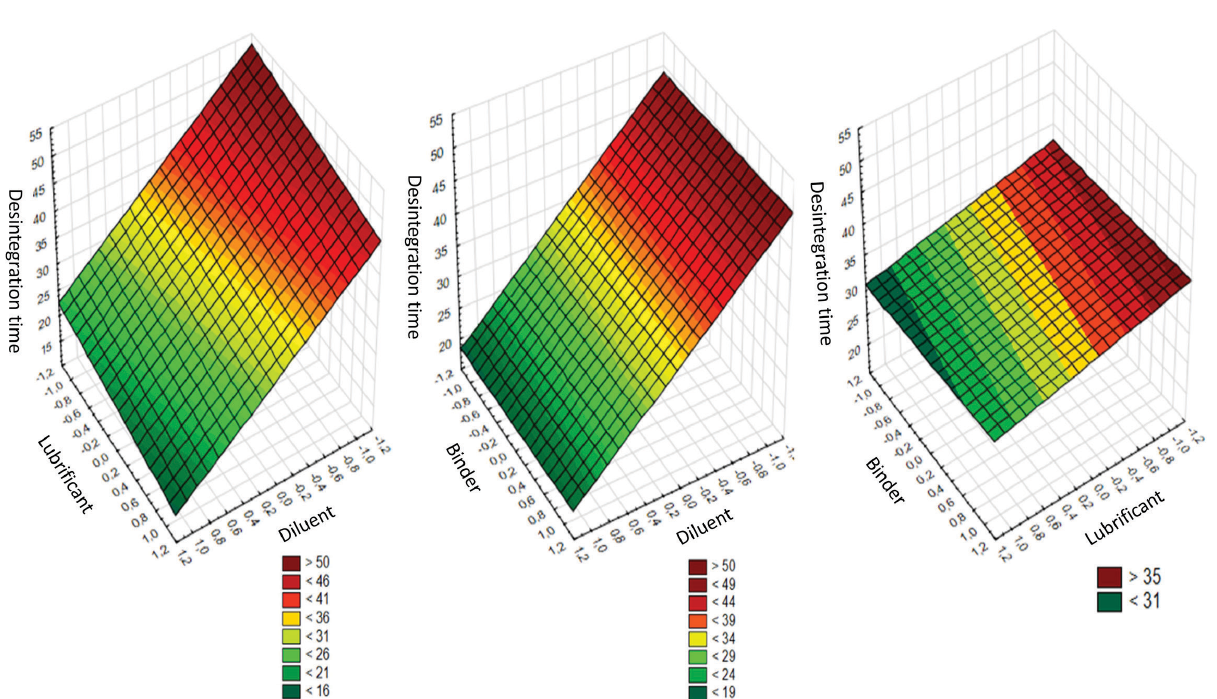
FIGURE 4 - Surface graphics of factorial planning 2 3 for effects produced in disintegration time (min), from the factors: diluent (cellulose -, babassu +); use of PVP as a binder (no -, yes +), lubricant (0.5% -; 1.0%